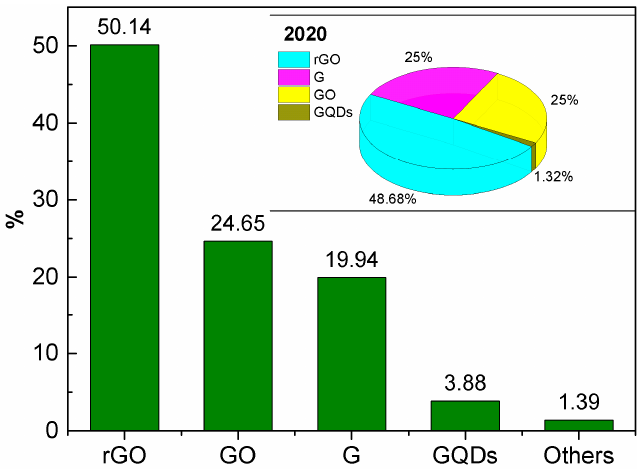
Figure 11. Type of carbonaceous support most used for ZnO–graphene